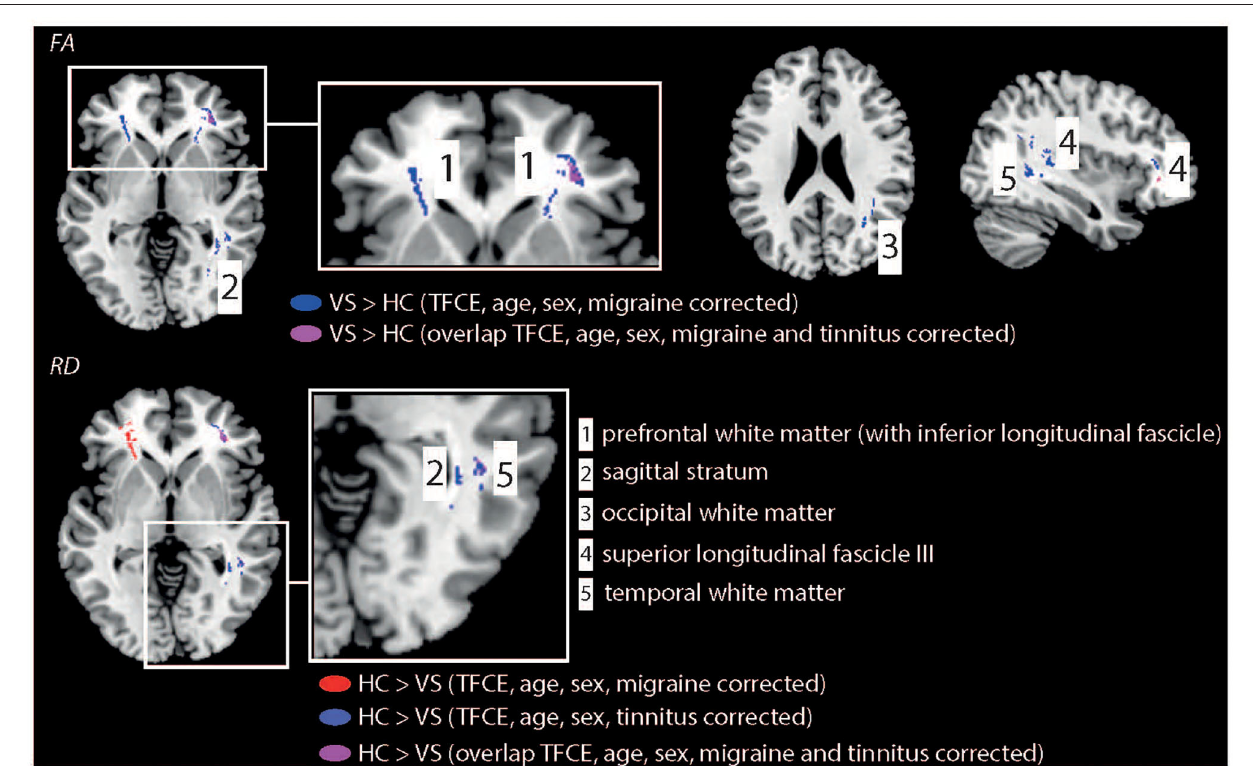
FIGURE 2 | Illustration of WM changes for the statistical comparison “HCs vs. patients with VSS.” Patients demonstrated higher FA values in multiple brain regions. In contrast, HC showed higher RD values compared to patients with VSS. Results were TFCE corrected and corrected for age, sex, and additionally for migraine or